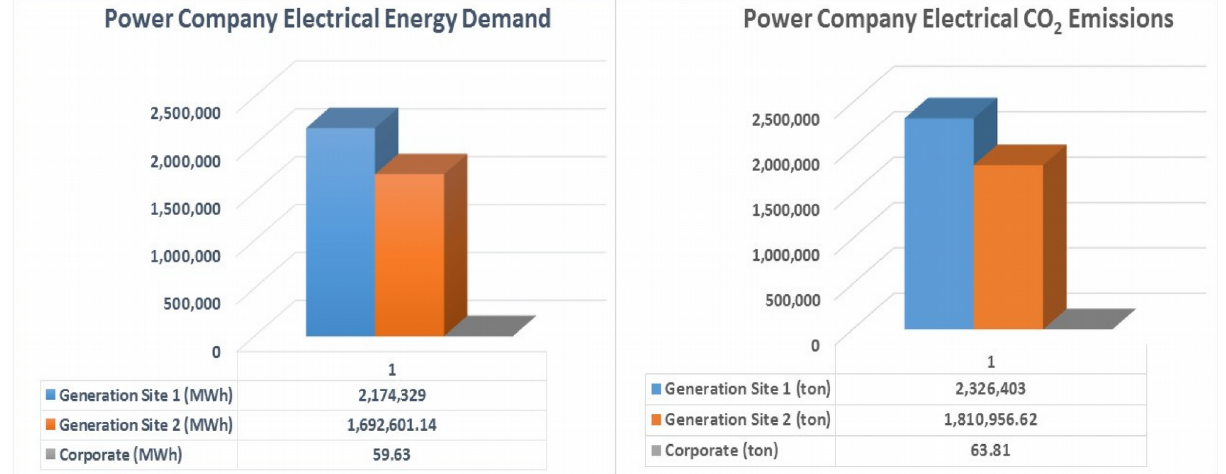
Figure 3. Electrical energy demand and CO